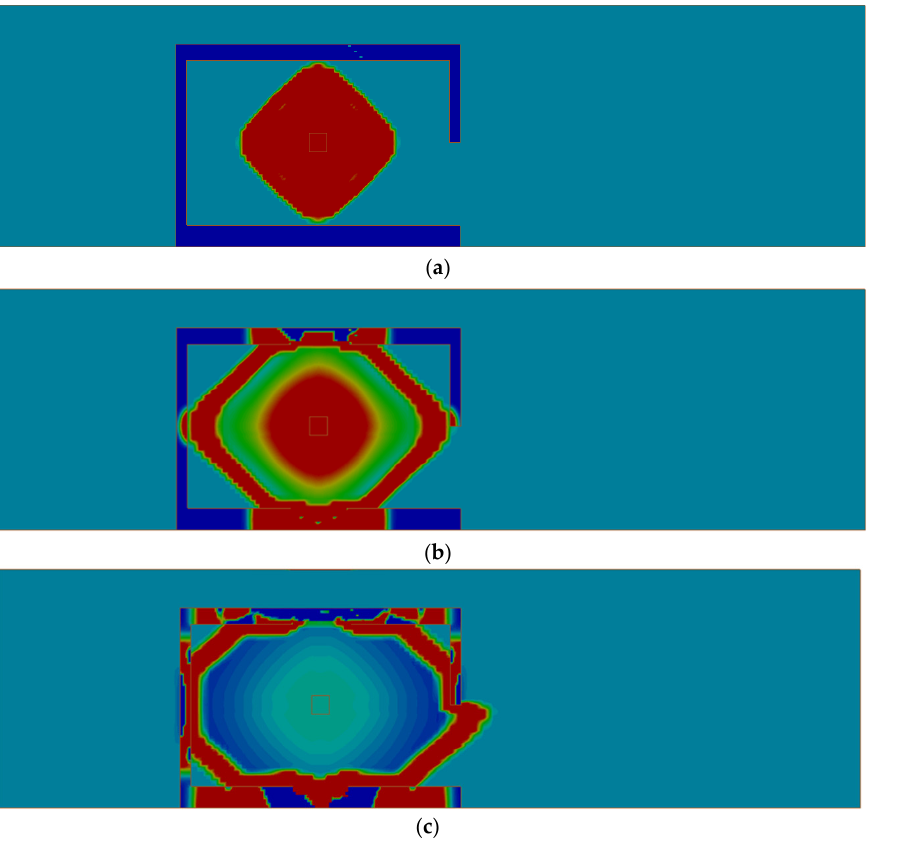
Figure 18. Pressure-time histories at different locations; ( a ) location of measuring points; ( b ) inter- nal; ( c ) external.